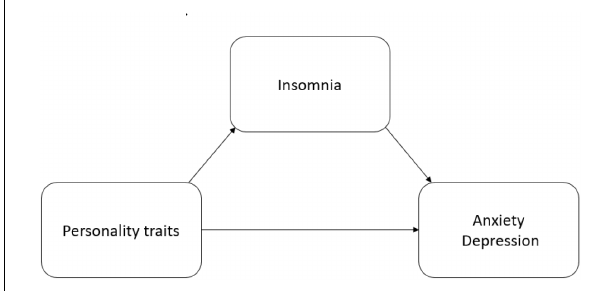
FIGURE 1 | Hypothesized model of direct and indirect relationships between the latent